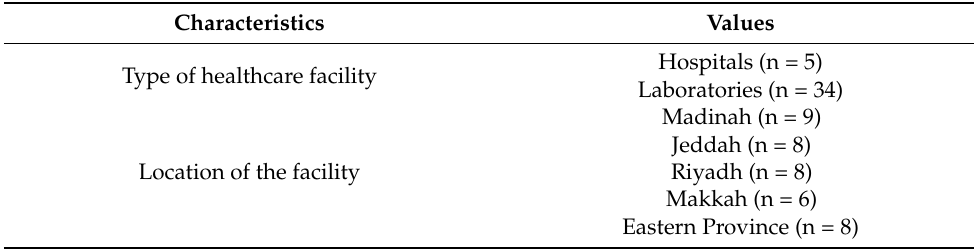
Table 1. The healthcare facilities included in the study.